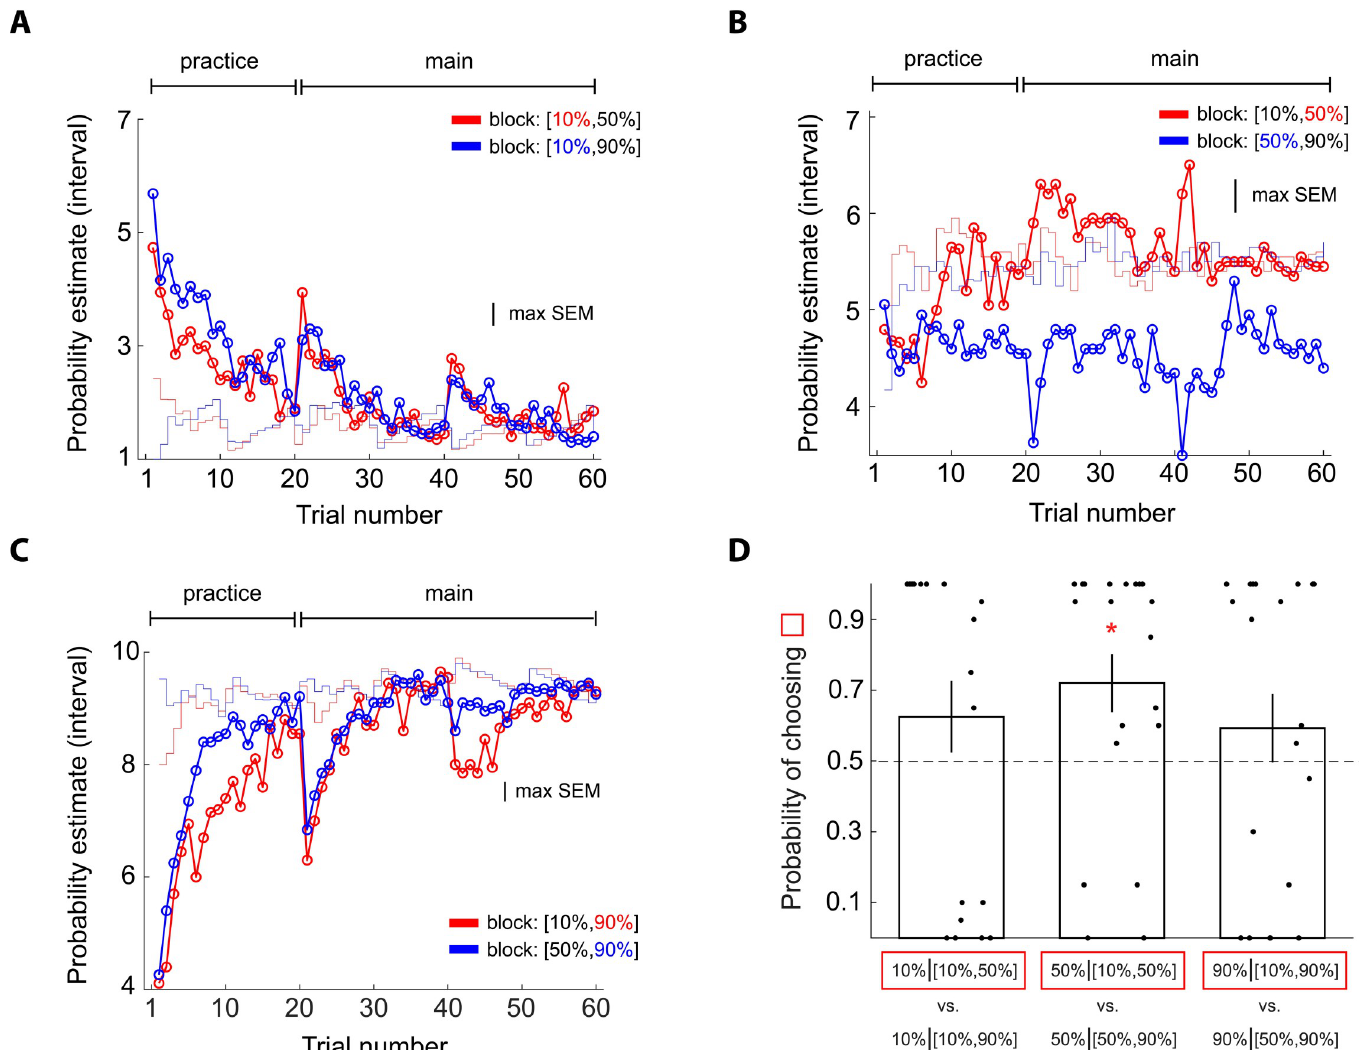
Fig 14. Experiment 6: Using an incentive-compatible design to examine context effects on probability estimates at 10%, 50%, and 90% reward and replicating the context effects seen in Experiments 1 and 2. Conventions are the same as in Fig 5. The design principle of the experiment was identical to the design of Experiments 1 and 2 (Fig 1B) except that we provided monetary incentives to the subjects to give accurate probability estimates. (A) Probability estimates of 10% reward. (B) Probability estimates of 50% reward. (C). Probability estimates of 90% reward. (D) Choice probability in the lottery decision task after the probability estimation task. Error bars represent ± 1 SEM. The red star symbol indicates a significant difference from 0.5 based on 95% bootstrap confidence interval. Data underlying these graphs can be found in https://osf.io/48j7m.